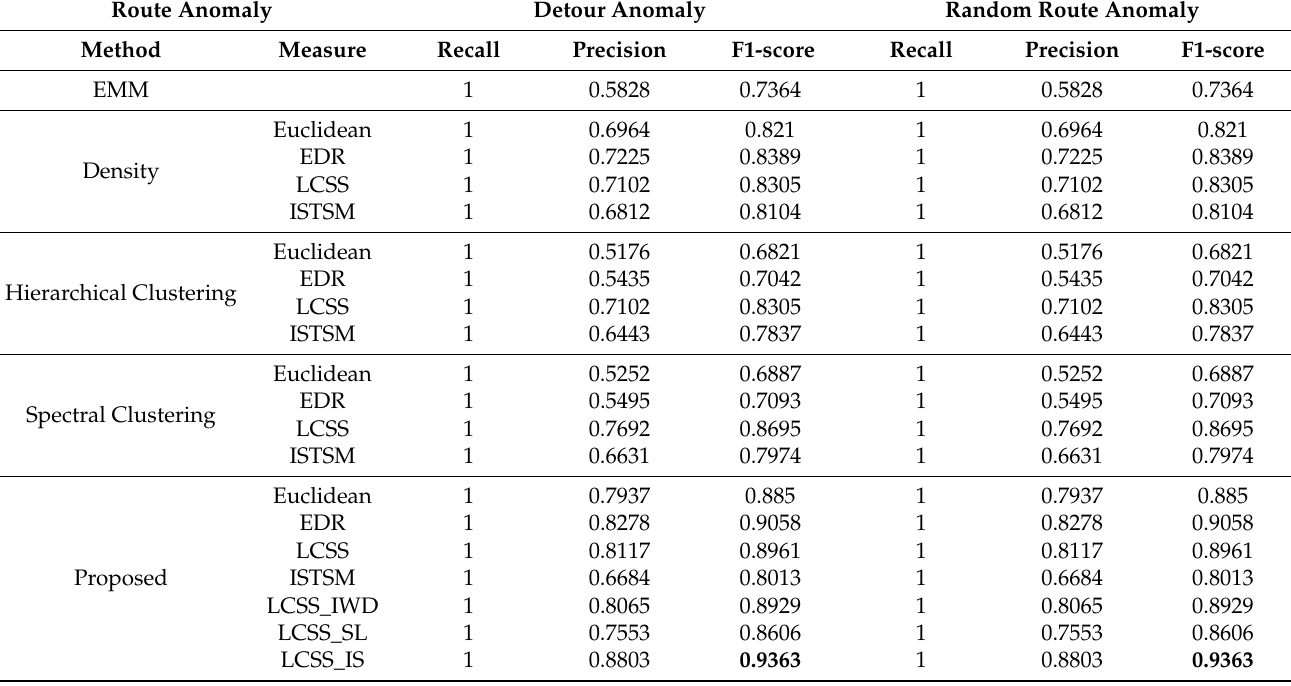
Table 6. Results with route anomalies on the sCREEN